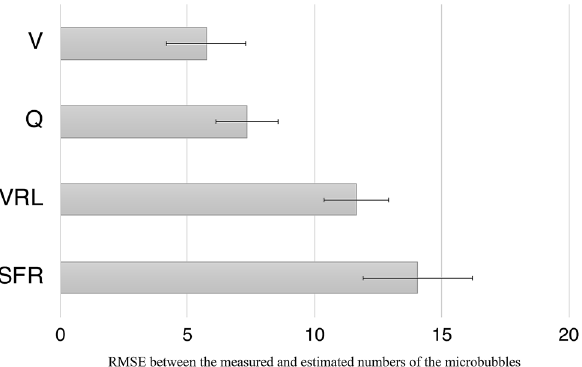
Figure 7. Histogram showing the evaluated the input factors to the neural network based on their permutation importance. The root mean squared error (RMSE) between the measured and estimated numbers of the microbubbles shown in the horizontal axis was used as the evaluation item: Q blood perfusion flow rate, V blood viscosity, VRL venous reservoir level, and SFR: surgical field suction flow